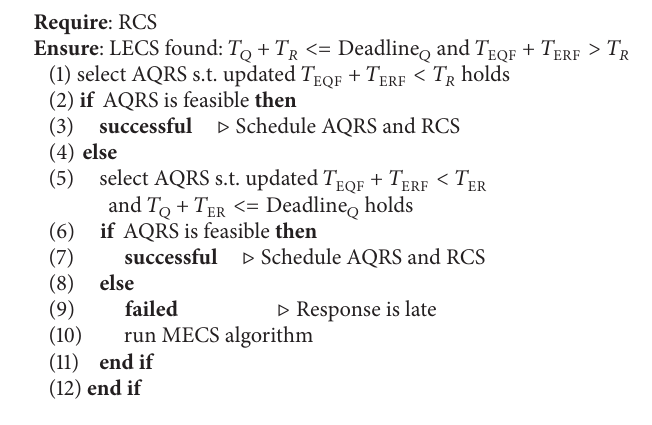
Algorithm 2: Calculate Optimum Energy Consuming Schedule.